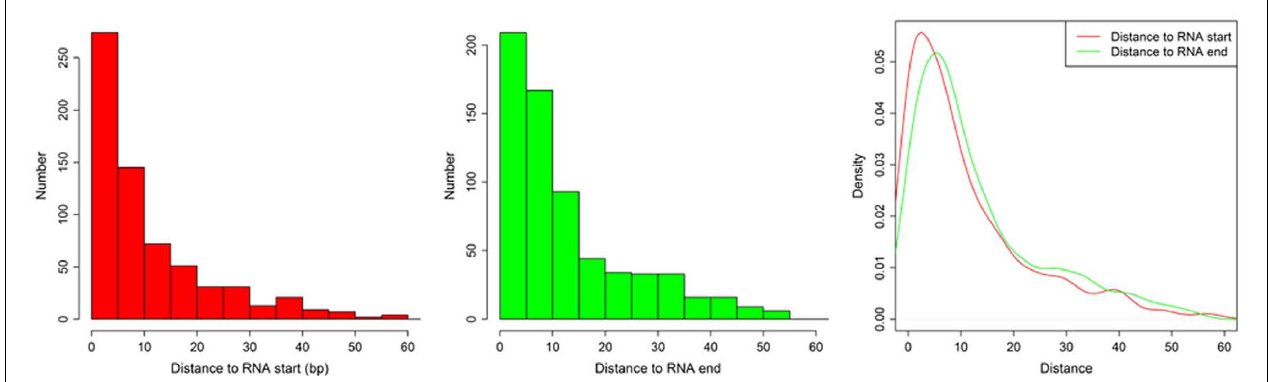
FIGUREA3 |The distances between (1) motif start and RNA 5 (cid:2) end and (2) between motif end and RNA 3 (cid:2) end. The histogram shows the distance